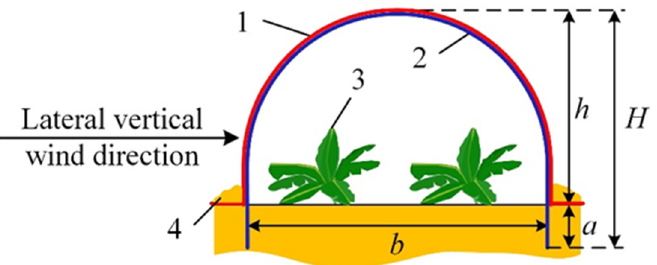
Figure 3. Schematic diagram of vertical wind on the side of arch shed. 1: plastic film; 2: arch shed pillar; 3: plant; and 4: soil. Note that b: span of arch shed pillar; H: height of arch shed pillar; h: height of arch shed and a: the embedded depth of the arch shed pillar.